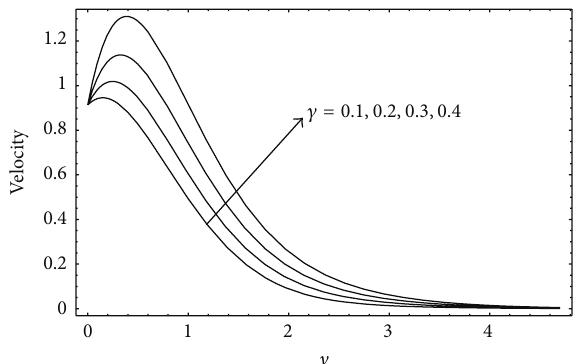
Figure 8: Velocity profiles for different values of 𝛾 when 𝑡 = 0.4, 𝑅 = 3, Pr = 0.71, Gr = 5, Gm = 2, Sc = 0.78 , and 𝜔 = 𝜋/3 .